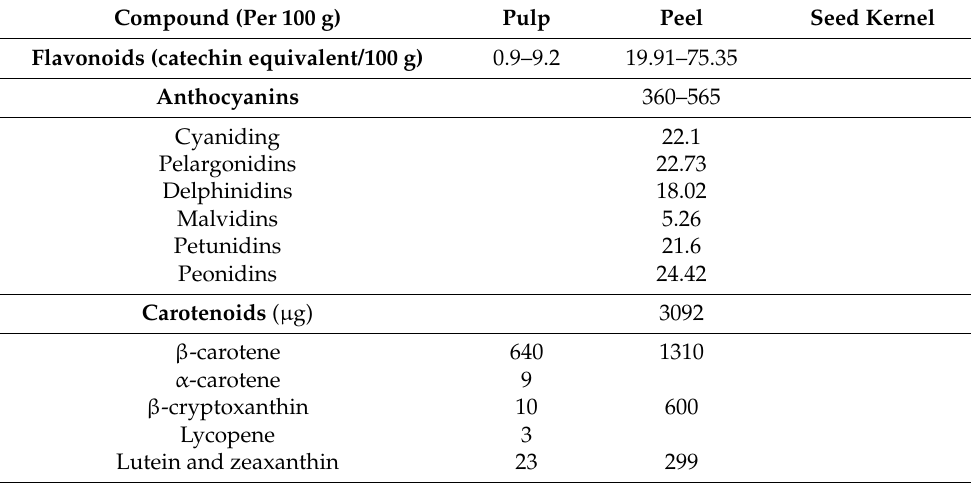
Table 1. Cont . Compound (Per 100 g) Pulp Peel Seed Kernel Flavonoids (catechin equivalent/100